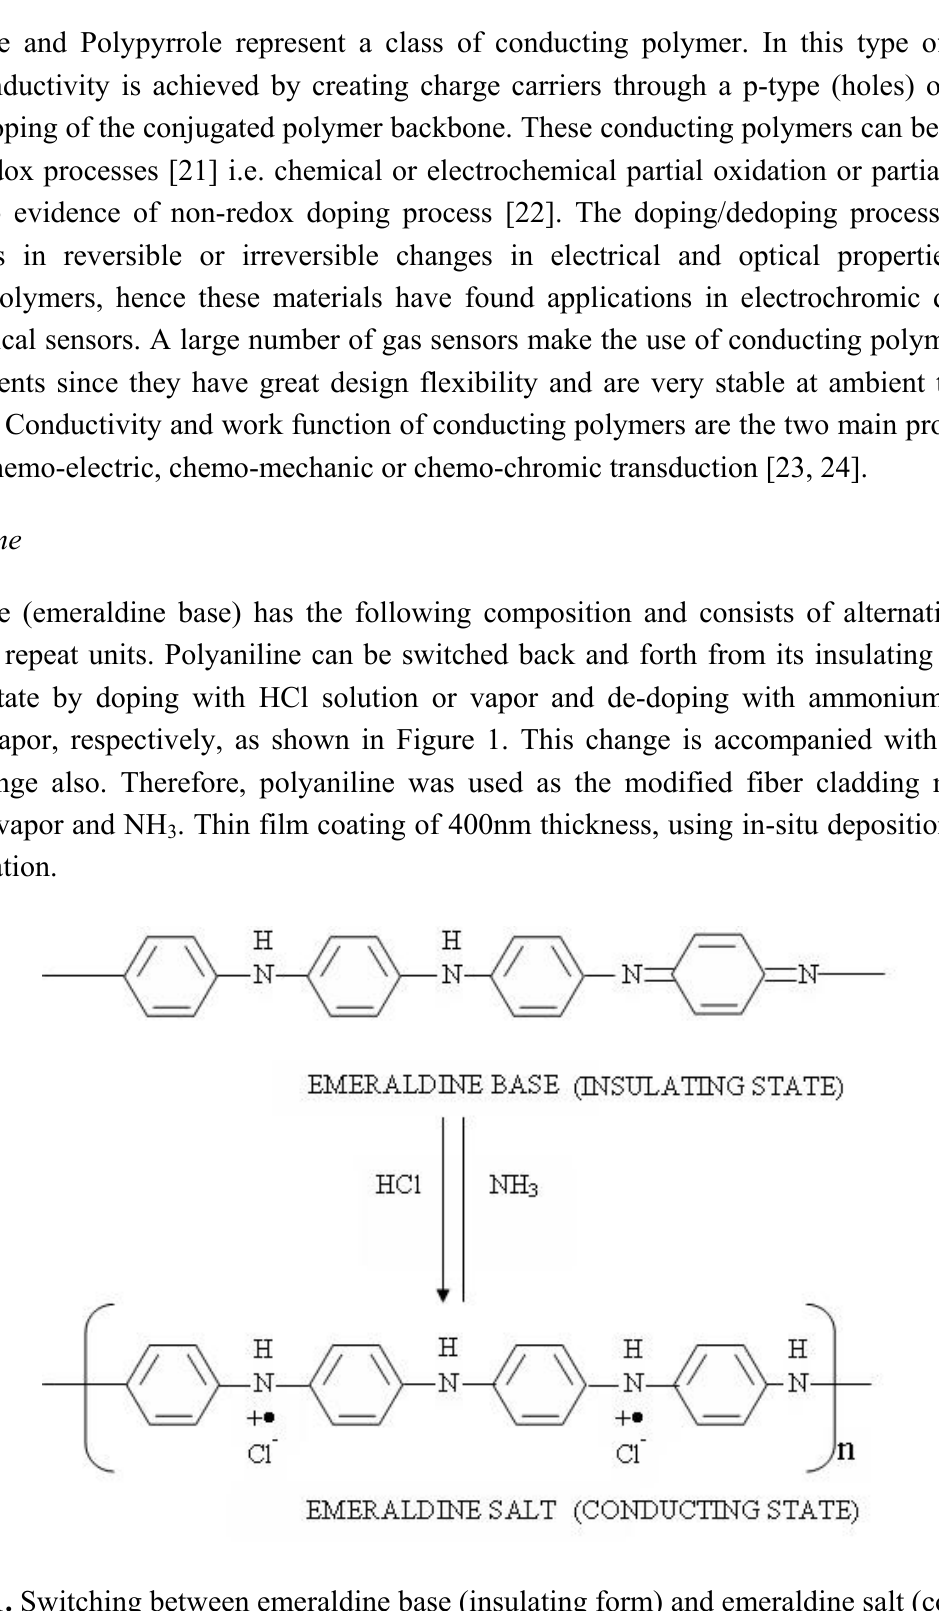
Figure 1. Switching between emeraldine base (insulating form) and emeraldine salt (conducting form) by HCl and ammonia,